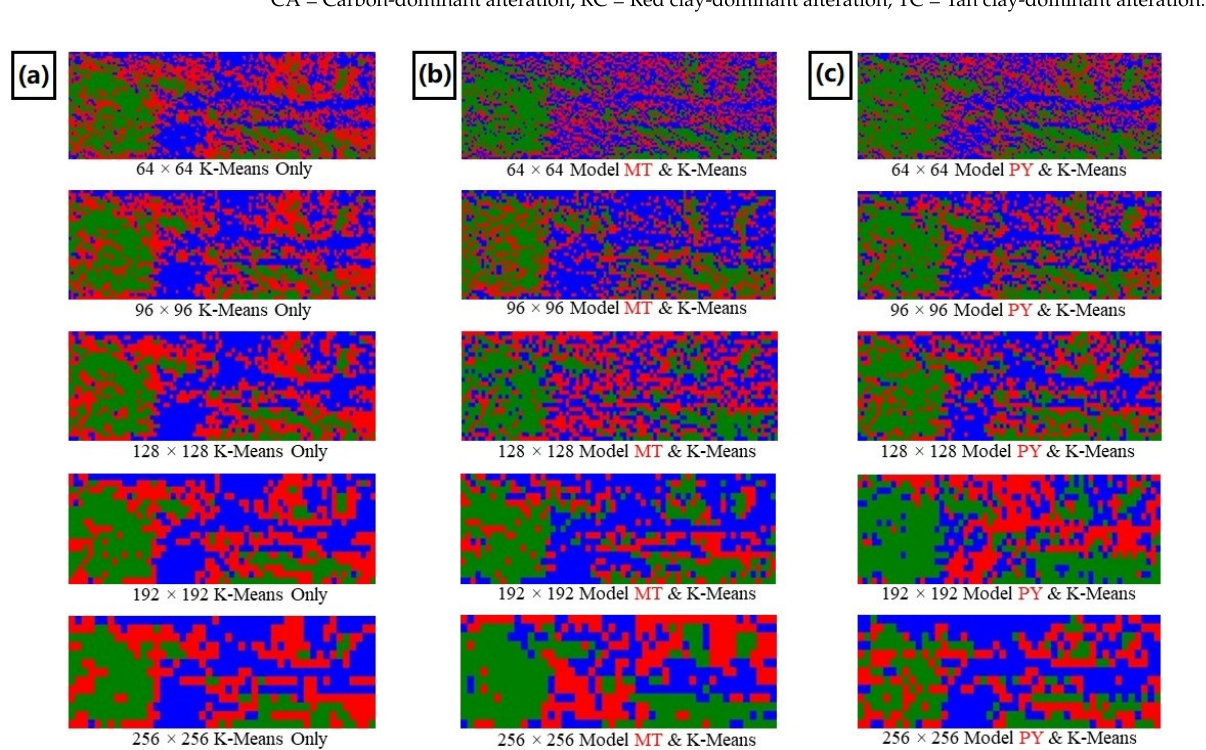
Figure 10. Coloured cluster maps of the Pick Pit pit wall orthomosaic. Colour assignment of the cluster groups was based on visual comparison to the ground truth in terms of spatial correspond- ence. ( a ) The K-Means clustering-only map; ( b ) the autoencoder-first (Model MT) K-Means cluster- ing map; ( c ) the autoencoder-first (Model PY) K-Means clustering map.